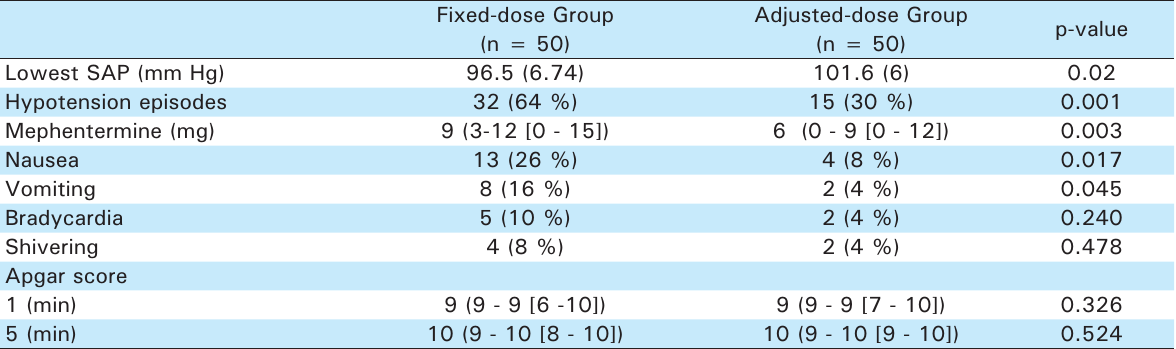
Table 4. Haemodynamic data, adverse effects and APGAR score